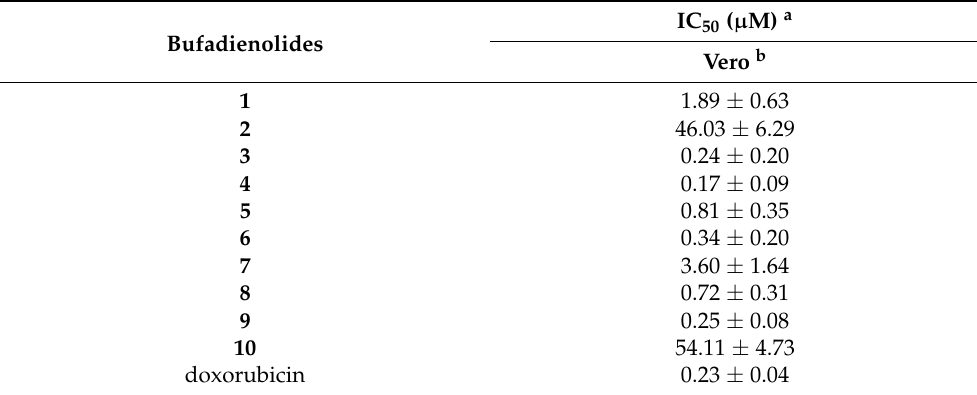
Table 3. Cytotoxic activity of bufadienolides isolated from R. alata